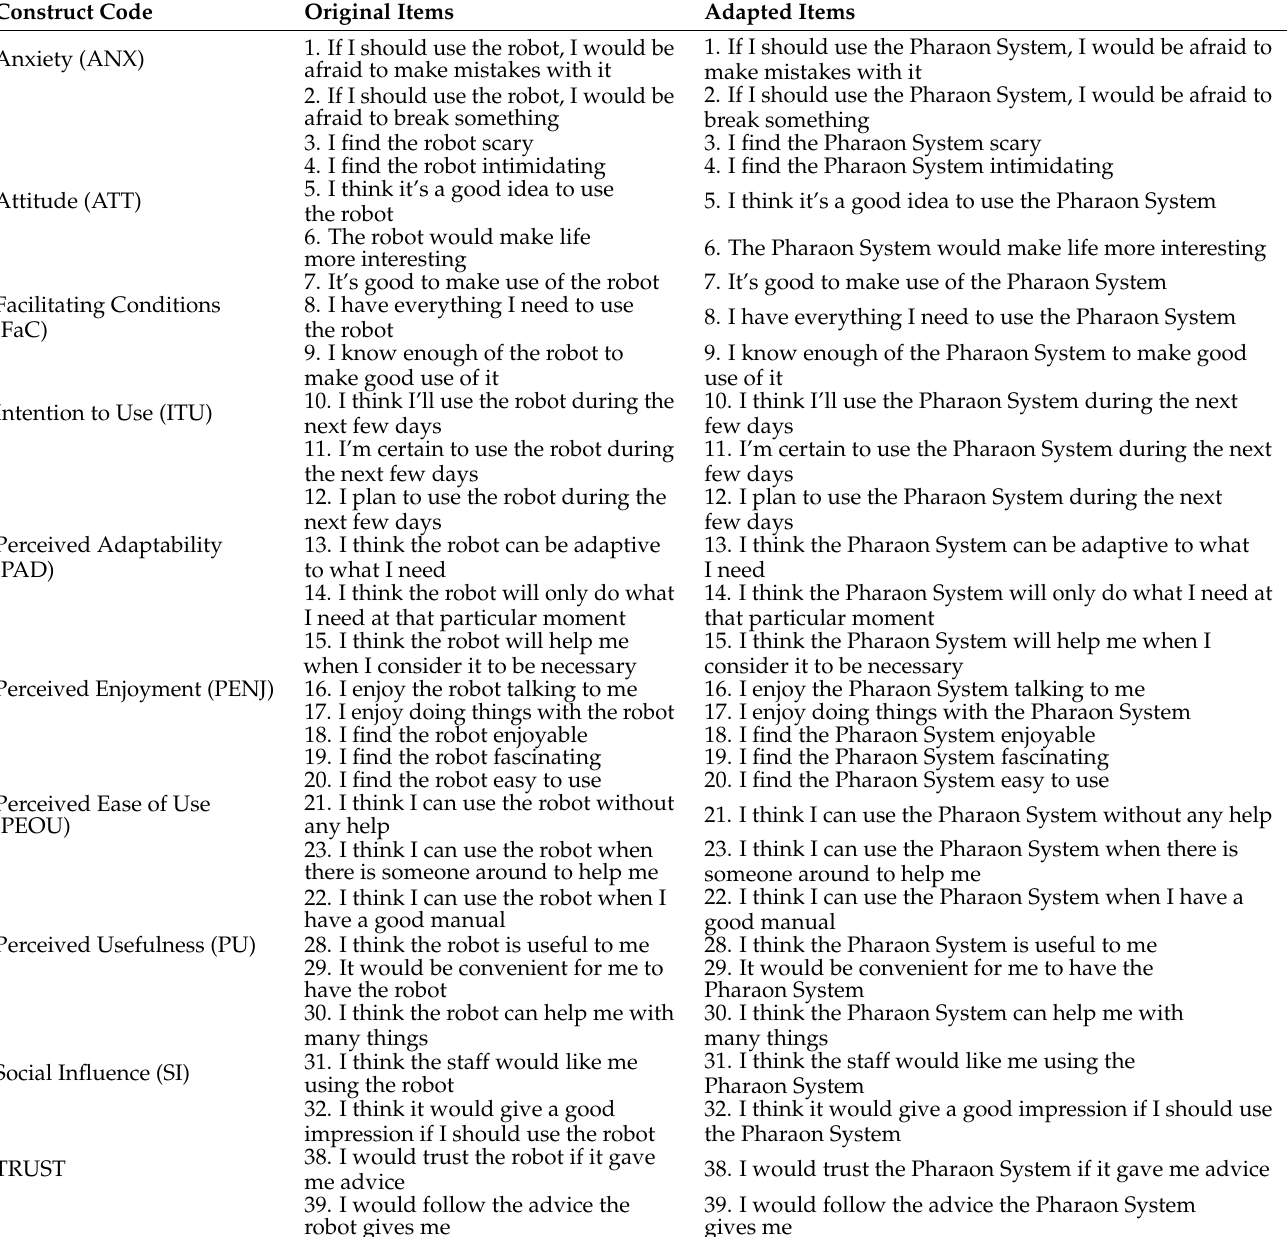
Table A1. Almere Model Questionnaire’s constructs and items used in Phase